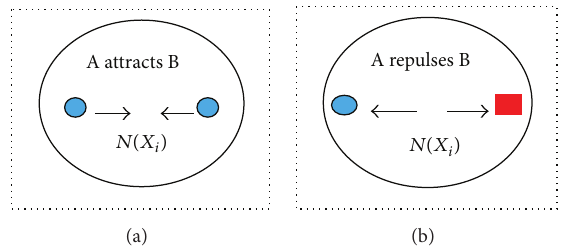
Figure 1: An intuitive demonstration of within-class attraction and between-class repulsion between pairwise points, where the circle denotes 𝑘 nearest neighbors 𝑁(𝑋 𝑖 ) of 𝑋 𝑖 ; (a) A and B belong to the same class; (b) A and B belong to different